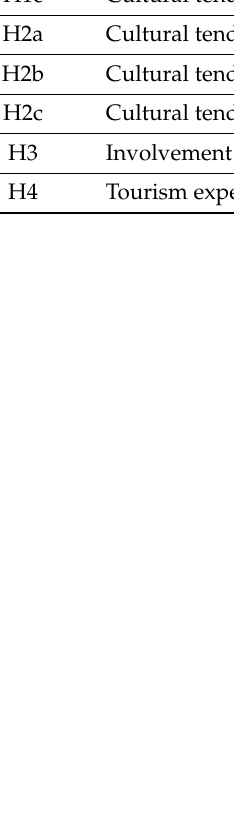
Table 8. The moderating effect of prior